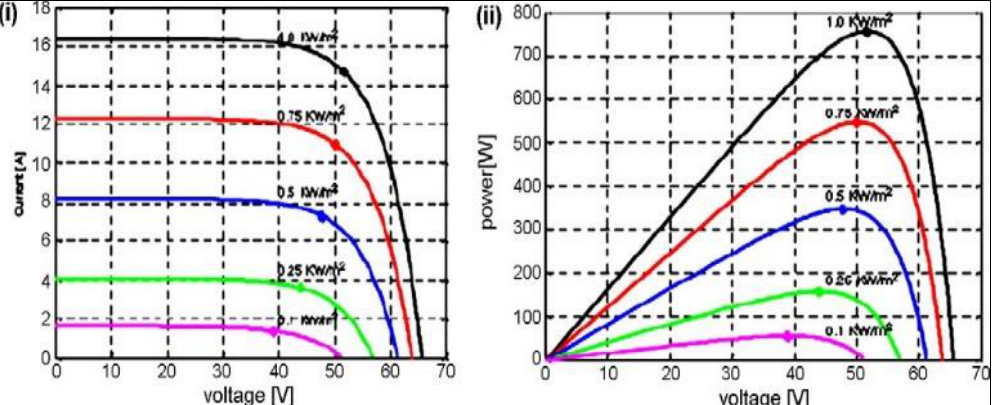
Figure 2: (i) Photovoltaic cells I-V curve and (ii) Photovoltaic cells P–V curve. Source: